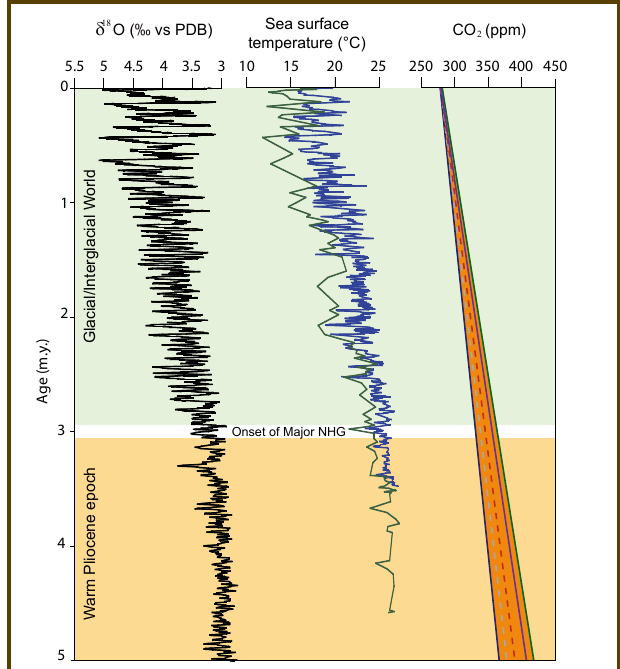
Figure 1. The Pliocene-Pleistocene climate transition illustrated by the increasing benthic δ 18 O (ice volume) trend (Lisiecki and Raymo, 2005), the sea surface temperature cooling in the Benguela Upwelling System (Marlow et al., 2000; Etourneau et al., 2009), and the alkenone-based atmospheric CO 2 decline (Pagani et al.,